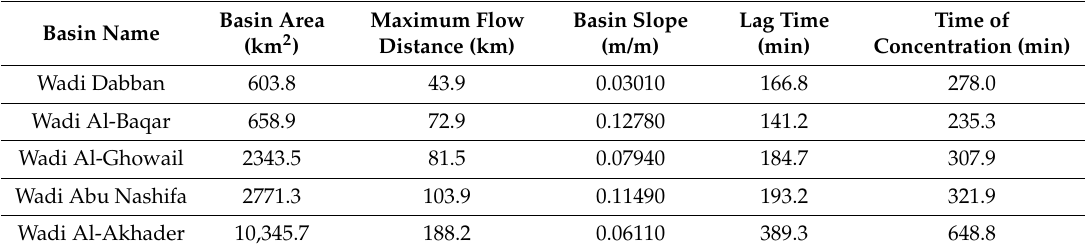
Table 3. Main morphological characteristics of the drainage